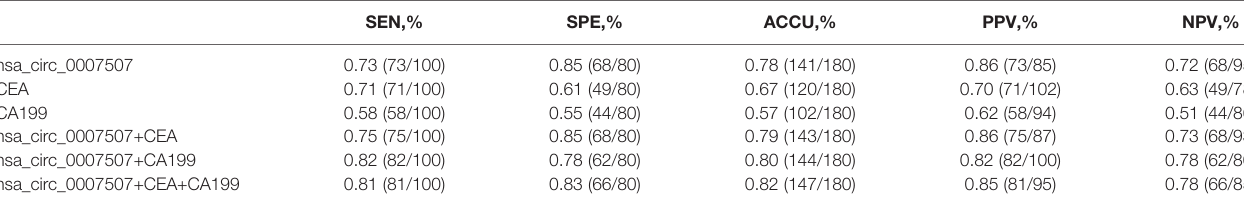
SEN, sensitivity; SPE, speci fi city; ACCU, overall accuracy; PPV, positive predictive value; NPV, negative predictive